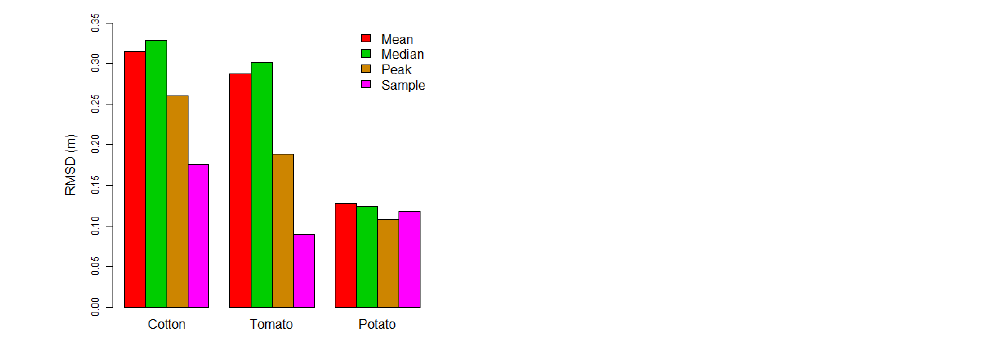
Figure 5. Root mean square differences (RMSD) between ruler measurements and crop heights derived from CHMs using four methods. One outlier for cotton (2020/08/02) was detected and removed from the height and K c models, and an additional outlier (2020/09/02) was detected and removed from the K c model alone. Three outliers for tomato were detected and removed only from the K c mod-